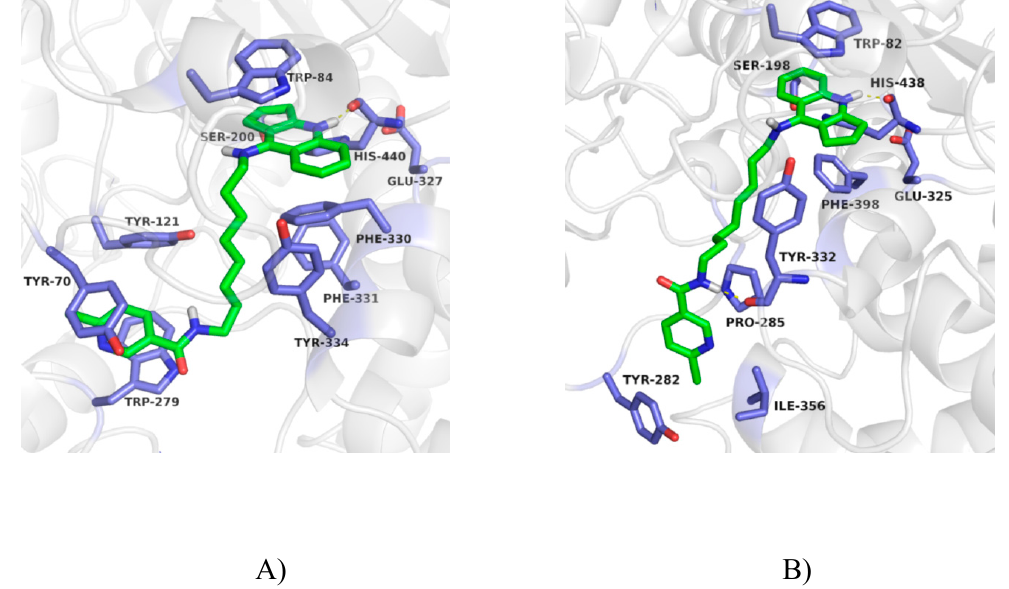
Figure 5. Binding mode of compound 3g with acetylcholinesterase ( A ) and butyrylcholinesterase ( B ).